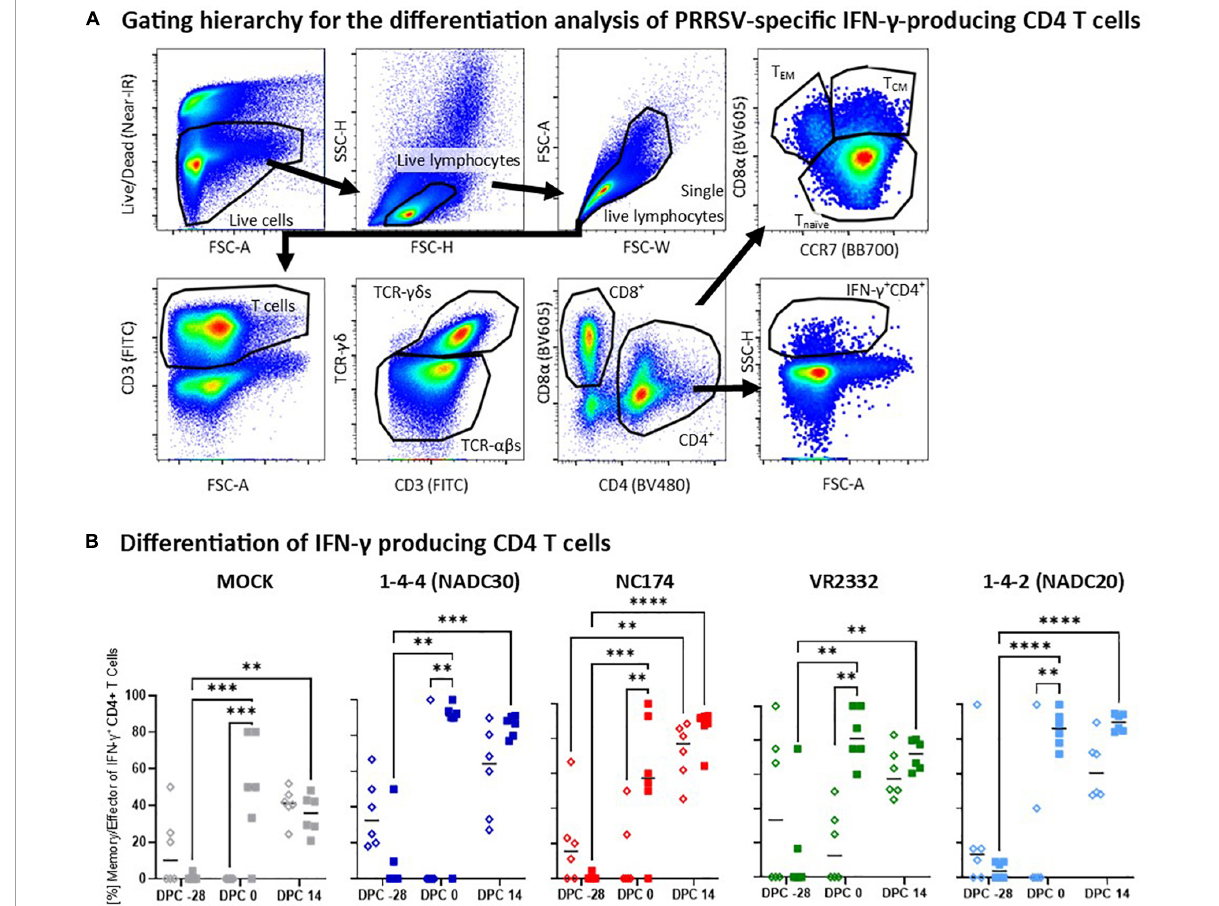
FIGURE7 Heterologous vaccine immunogenicity—differentiation of IFN- γ producing CD4 T cells. Panel (A) shows the gating hierarchy to assess the differentiation of IFN- γ producing CD4 T cells. After gating on IFN- γ + CD4 T cells as described in Figure 6 , their differentiation was analyzed via their CD4/CD8 α expression profile to distinguish naïve (CCR7 + CD8 α - ), central memory (T CM , CCR7 + CD8 α + ) and effector memory (T EM , CCR7 - CD8 α + ) CD4 T cells (top right plot). Since the vast majority of CD8 α + IFN- γ -producing CD4 T cells belonged to the T CM subset (d.n.s.), both T CM and T EM were combined in the downstream analysis into the “memory/effector” subset. Panel (B) shows the frequency of these memory/effector within IFN- γ -producing CD4 T cells according to their challenge groups—MOCK (gray), 1-4-4 (NADC30, dark blue), NC174 (red), VR2332 (green), and 1-4-2 (NADC20, light blue). The black bars represent the median values; in addition, individual data points are shown for MOCK vaccinated animals (open diamonds) and MLV vaccinated animals (filled squares). Data were statistically analyzed using a 2-way ANOVA with time and vaccination as the two parameters and Tukey’s multiple comparison test. ∗∗∗∗ p < 0.0001, ∗∗∗ p < 0.001, ∗∗ p <